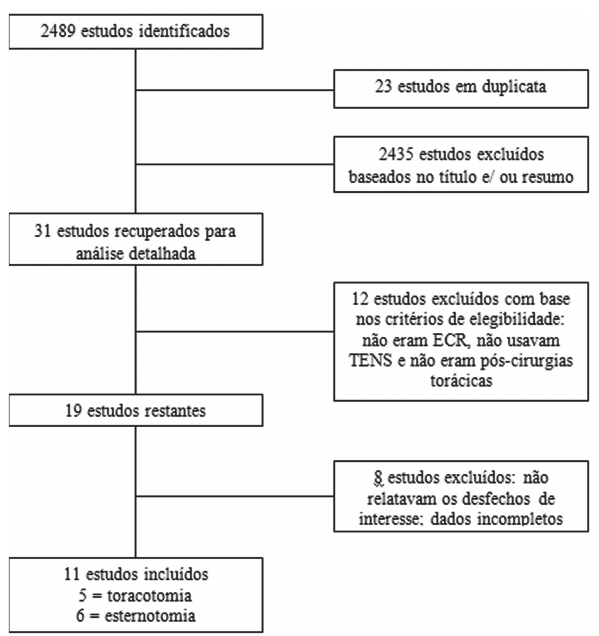
Fig. 1 – Fluxograma dos estudos incluídos na revisão. ECR = ensaio clínico randomizado; TENS = estimulação elétrica nervosa